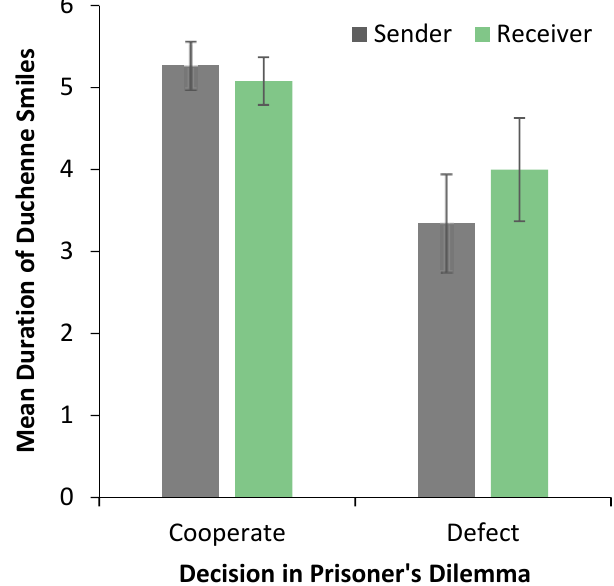
Figure 1. Mean duration (seconds) of Duchenne smiles during the discussion period. Error bars represent ± 1 SE. Adapted from [28].